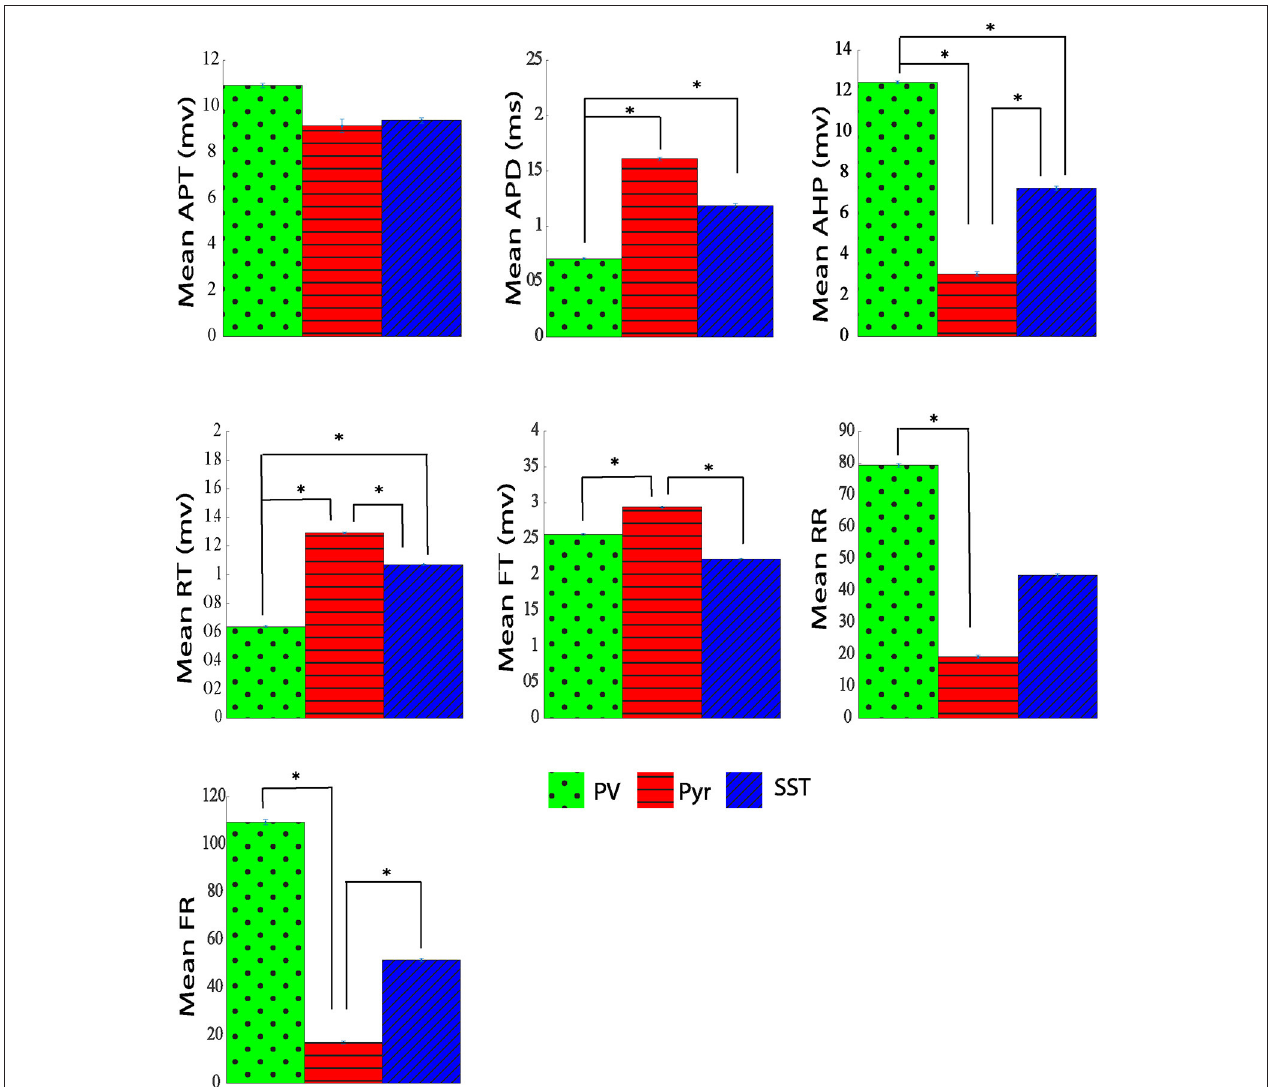
FIGURE 7 | The Comparison of physiological parameters extracted from action potential shape for three different types of neurons. All data shown mean ± standard error (APT, action potential threshold; APD, action potential duration; AHP, After hyperpolarization; RT, rise time; FT, fall time; RR, rise rate; FR, fall rate. *adjusted p value ≤ 0.05,